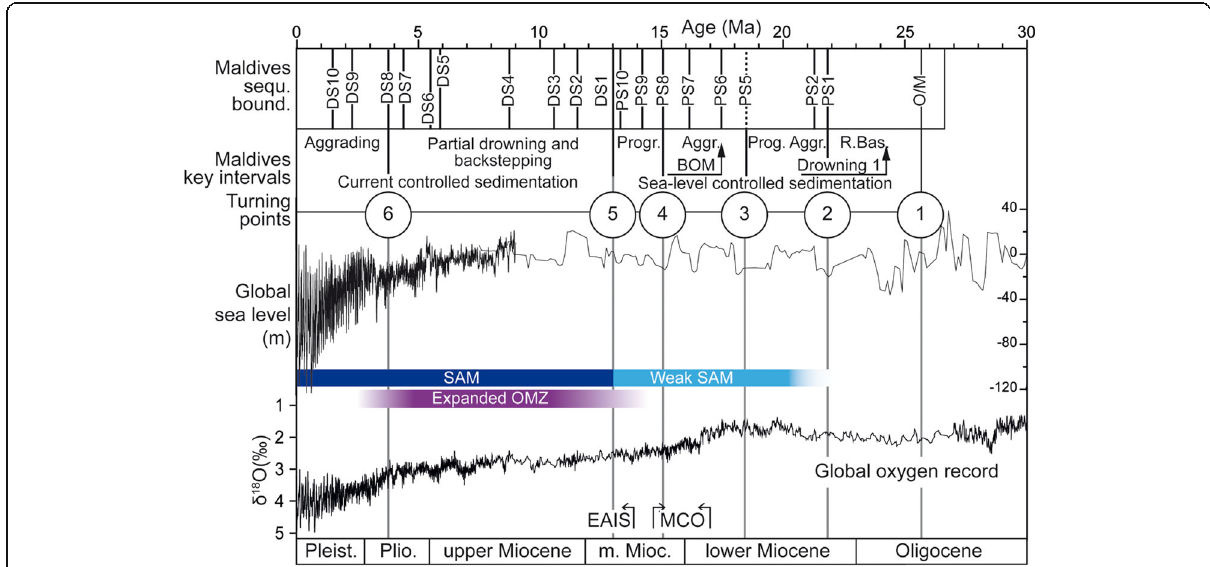
Fig. 8 Oligocene to Miocene evolution of the Maldives carbonate platform with ages of the sequence boundaries and key intervals representing changes of platform configuration. The global sea level curve is from Miller et al. (2005). The intensity of the South Asian Monsoon (SAM) and the expansion of the Oxygen Minimum Zone (OMZ) are after Betzler et al. (2016a). The global oxygen record is taken from Zachos et al. (2001). MCO Miocene Climate Optimum (after Holbourn et al. 2005, 2015), EAIS East Antarctic Ice Sheet expansion (after Holbourn et al. 2005), BOM Backstepping of the outer margin. Numbers in circles denominate turning points of the platform evolution; see text for